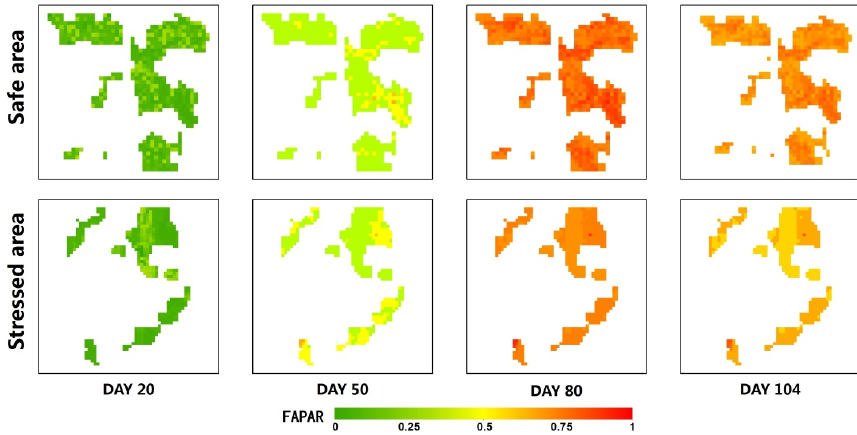
Figure 8. Spatial-temporal distri9bution of FAPAR in the two areas. Note that all days mean day after transplanting and non-rice pixels are shown in white.